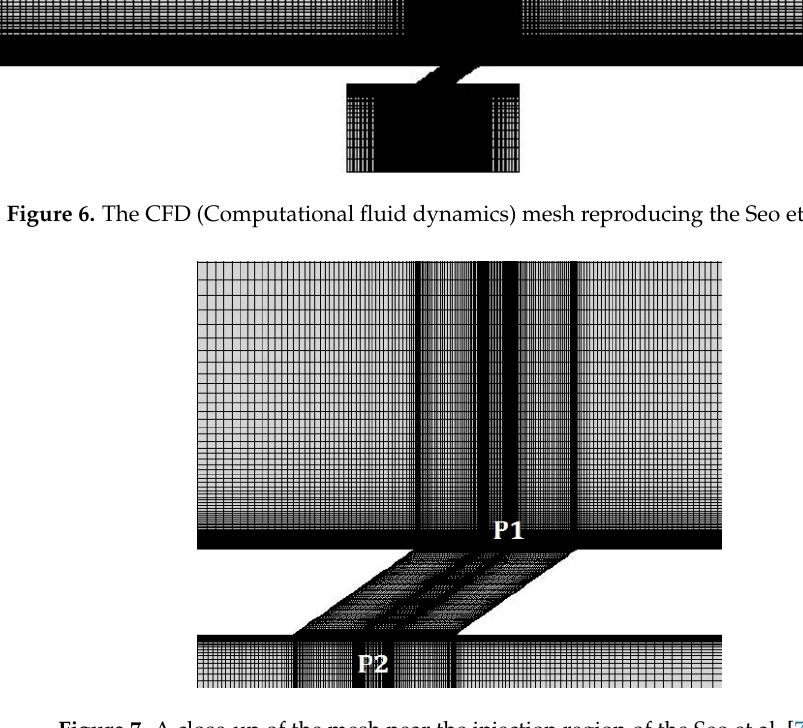
Figure 7. A close-up of the mesh near the injection region of the Seo et al. [7] case. Table 1. The boundary conditions for the computational domain [28].